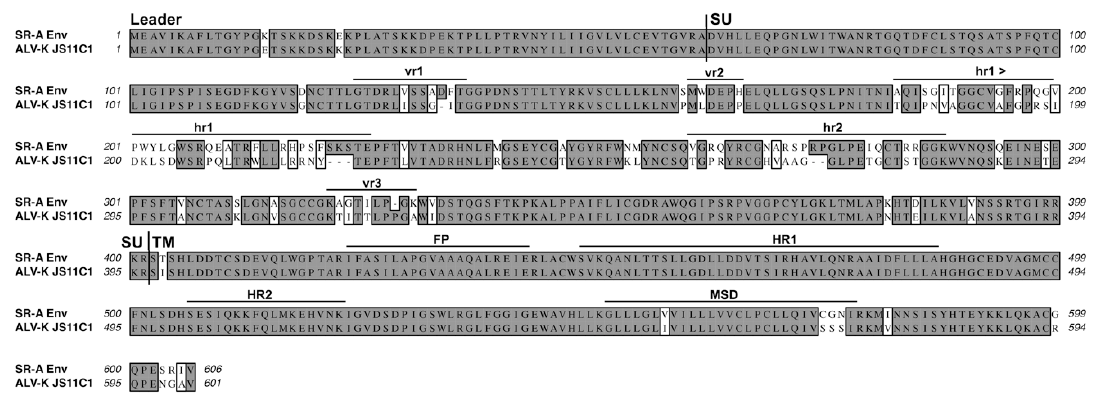
Figure 10. A comparison of the SR-A subgroup A and the JS11C1 subgroup K envelope glycoproteins. See Figure 2 legend for analysis details. JS11C1, Genbank #KF46200.1.